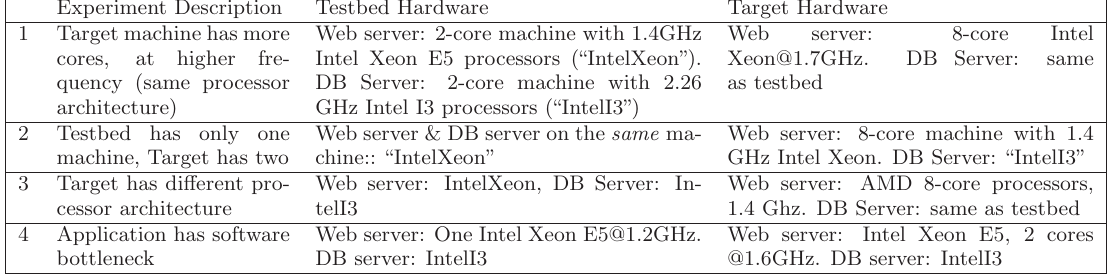
Table 1: Testbed and Target Hardware Descriptions of all